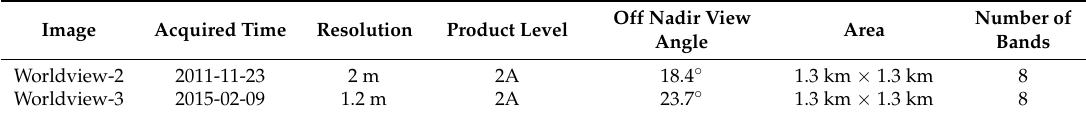
Figure 3. The experiment images and reference information with changed areas are delineated by red polygons and unchanged areas by green polygons: ( a ) true color synthesis of a Worldview-2 image acquired at November 2011; ( b ) true color synthesis of a Worldview-3 image acquired at February 2015. Table 1. Information of Worldview-2/3